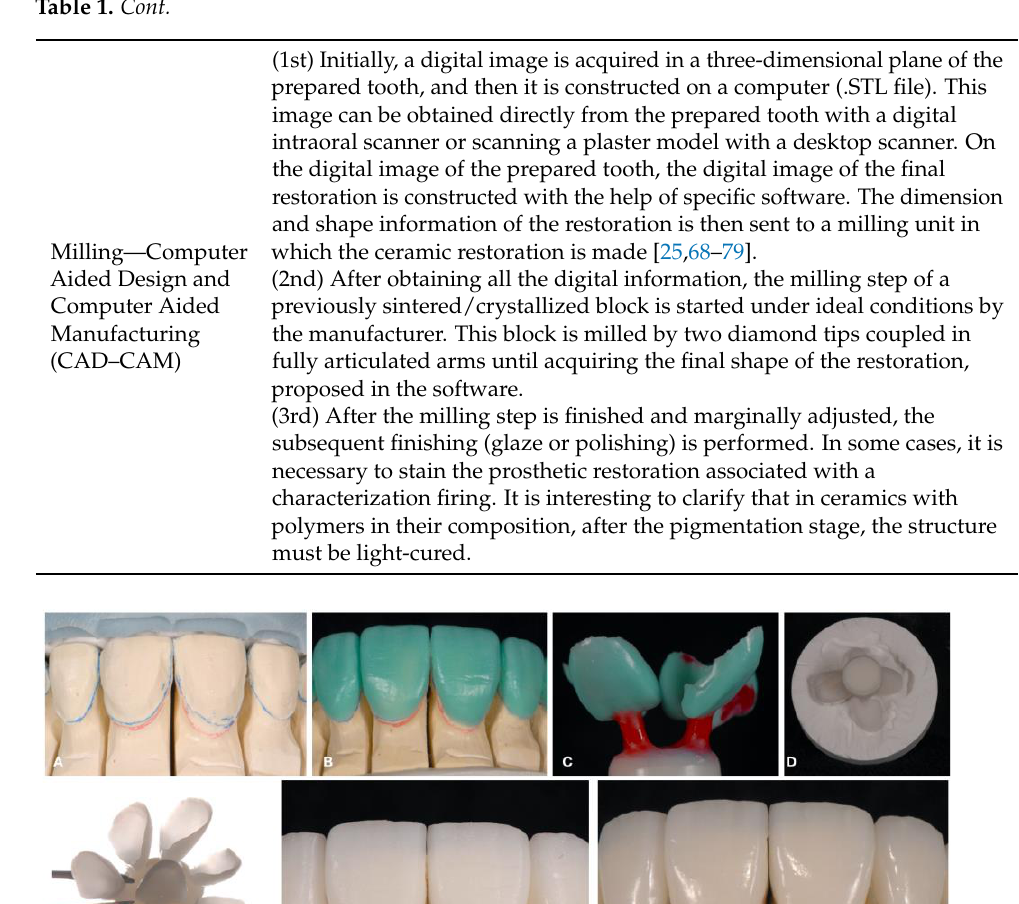
Figure 2. Pressed technique. ( A ) Stone model and putty matrix from diagnostic wax-up; ( B ) Wax-up; ( C ) Sprueing, investing, and pressing; ( D ) Divesting; ( E ) Removing the reacting layer; ( F ) Staining, firing, and glaze; ( G ) Final restoration.